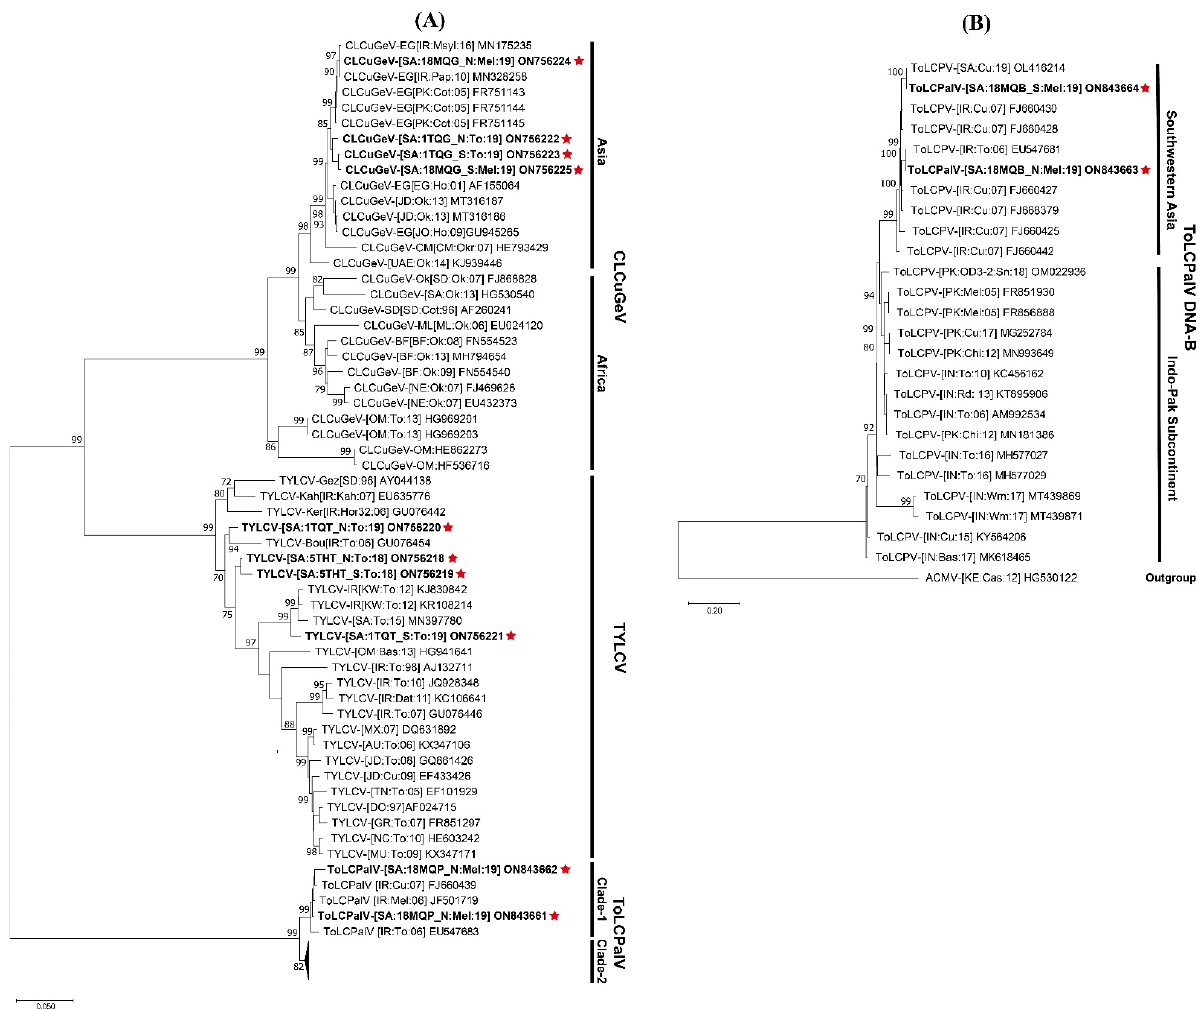
Figure 2. Maximum likelihood phylogenic dendrograms showing the evolutionary relatedness of ( A ) full-length genomes of identified cotton leaf curl Gezira virus (CLCuGeV), tomato yellow leaf curl virus (TYLCV), tomato leaf curl Palampur virus (ToLCPalV) DNA-A, and ( B ) ToLCPalV DNA-B. In each case, the full-length sequences of the most closely related begomvovirus genomes were retrieved from the NCBI GenBank database for comparison with the identified respective begomovirus genomes. The host plant species, geographical origins, and database accession numbers of each isolate used in this tree have been included. The begomovirus isolates identified in this study are written in bold text and indicated with a red star. The trees were constructed with percentage bootstrap values set at 1000 replicates. For taxonomic abbreviations of begomovirus species, the guidelines by Zerbini et al. [1] were followed. The ToLCPalV isolates reported from the Indo–Pak subcontinent were merged. Abbreviations used for begomovirus species were cotton leaf curl Gezira virus (CLCuGeV), tomato yellow leaf curl virus (TYLCV), tomato leaf curl Palampur virus (ToLCPalV), and African cassava mosaic virus (ACMV). The sequences 1TQa_N, 1TQa_S, 18MQa_N, and 18MQa_S were 99.2–99.8% identical crinkle Cameroon alphasatellite (OYCrCMA) isolate (KC763633) reported from a